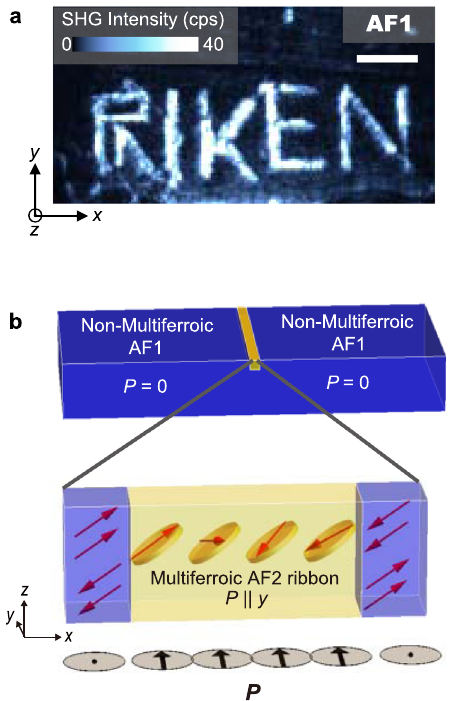
Fig. 4 Controlled writing of the multiferroic state into a non-multiferroic environment. a SHG image at the photon energy 2 _ ω ¼ 2 : 1 eV obtained at 6.5 K in the non-multiferroic AF1 phase. Letters were drawn onto the crystal surface with a scriber. Scale bar, 200 μ m. b Model of the AF1/AF2 phase coexistence. The bulk magnetic structure is of the collinear non-multiferroic AF1 type, whereas the spatially con fi ned ribbons show the AF2 multiferroic spiral spin structure. Note that the width of the AF1 – AF2 phase boundary can be zero as the onset of the magnetic spiral and, hence, of the magnetically induced electric polarization occurs immediately after crossing from the non-multiferroic into the multiferroic